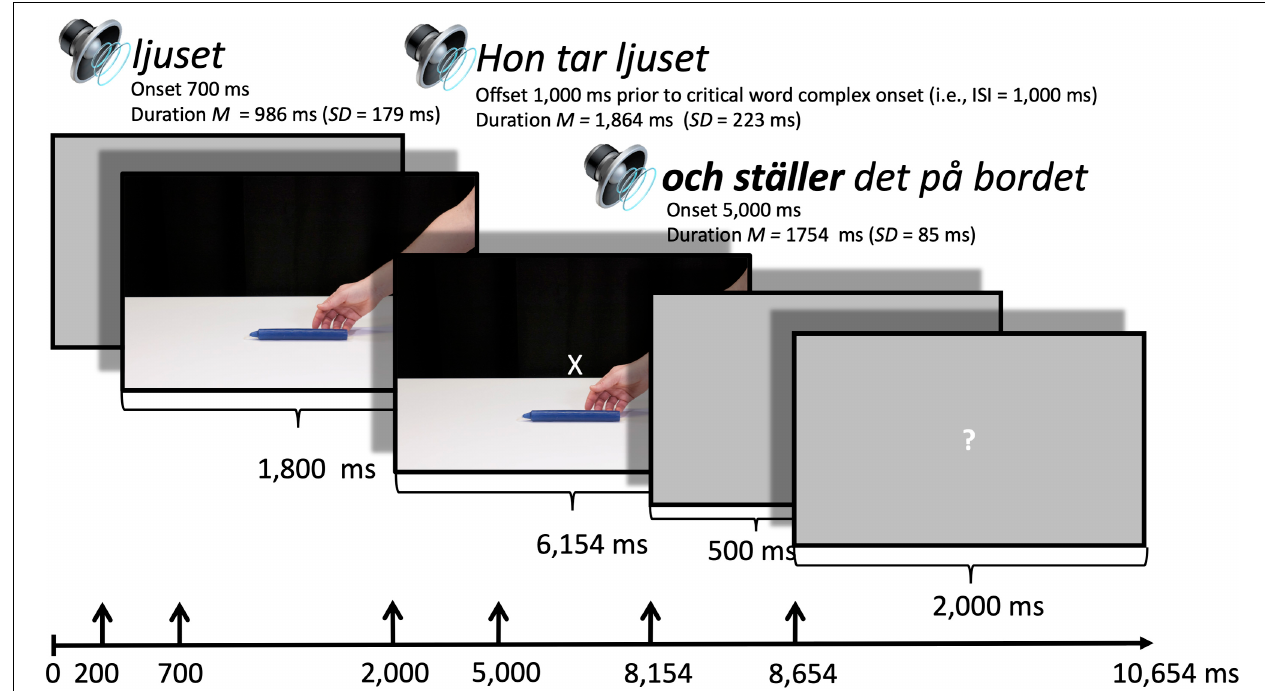
FIGURE 2 | ERP paradigm. A gray screen was presented for 200 ms after which the still frame filled the screen. A sound file with the name of the object was presented such that it ended at 2,000 ms after the gray screen appeared. A cross hair appeared on top of the still frame with the first clause sound file illustrated here with Hon tar ljuset “She takes candle.DET.” This sound file ended 1,000 ms (ISI) prior to the second clause which started with the critical word complex here visualized in bold (onsets at about 700 ms depending on the differing length of the sound files). The second clause of the sentence started after 5,000 ms. Following the end of the second sound file (ranging 1,615–1,840 ms), a gray screen appeared, and after a subsequent 500 ms, a question mark appeared to indicate that the participant should press the red or green button to indicate if the sentence described the event in an appropriate or not so appropriate manner.